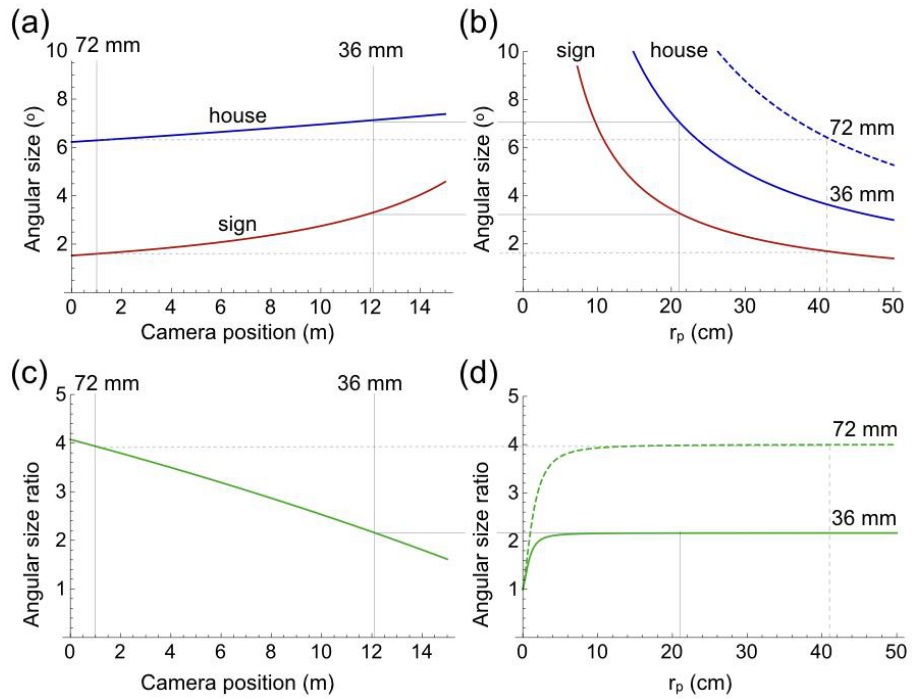
Figure 5. Angular size. ( a ) Angular sizes of the physical traffic sign (red) and house (blue) as function of camera position. The origin of the camera-position scale is given in Figure 2a. ( b ) Angular sizes of the depicted traffic sign (red) and house (blue) as function of viewing distance of the picture (r p ). The solid blue line shows the angular size of the house in the 36 mm picture of Figure 1a, the dashed blue line that of the house in the 72 mm picture of Figure 1b. ( c ) Ratio between angular sizes of the physical house and traffic signs shown in ( a ). ( d ) Ratio between angular sizes of the depicted house and traffic signs shown in ( b ). The horizontal solid line shows the ratio in the 36 mm picture and the dashed line in the 72 mm picture.